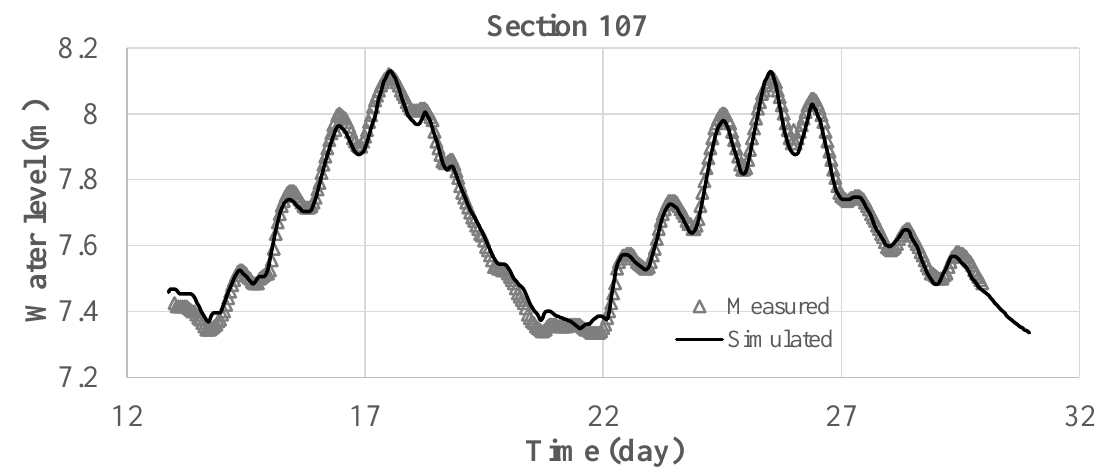
Figure 9. Water surface profiles with time at section 107.